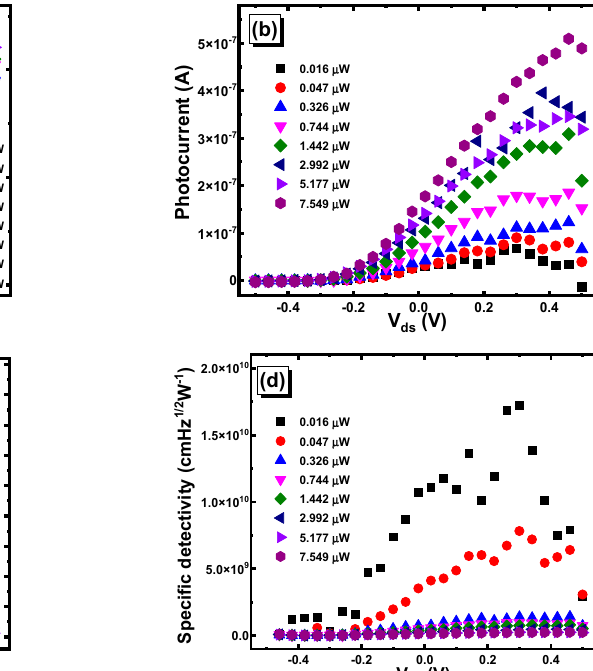
Figure 5. Polarization voltage and laser power dependence in n-MoSe 2 /p-BP heterojunction: ( a ) Out- put characteristics (I ds –V ds or I 32 –V 32 ), ( b ) photocurrent, ( c ) photoresponsivity, and ( d ) specific detec- tivity at gate voltage (V G or V 1 ) of − 0.5 V.